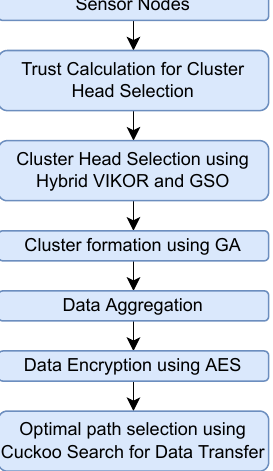
Figure 2. System architecture of